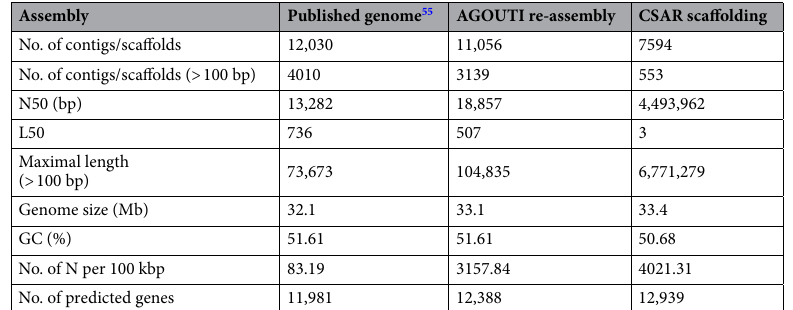
Table 1. Assembly summary statistics applied to the different assemblies of Alternaria dauci genome data set. AGOUTI re-assembly: re-assembly by the AGOUTI tool 56 of the published genome 51 helped by FRA001 transcriptome data obtained in this study. CSAR scaffolding: reference-based ( A. solani genome 57 ) genome re-assembly with the CSAR tool 58 . N50: length of the shortest contig/scaffold in the smallest subset of contigs whose length sum makes up half of genome size. L50 number of contigs in that subset. GC (%): guanine- cytosine content.